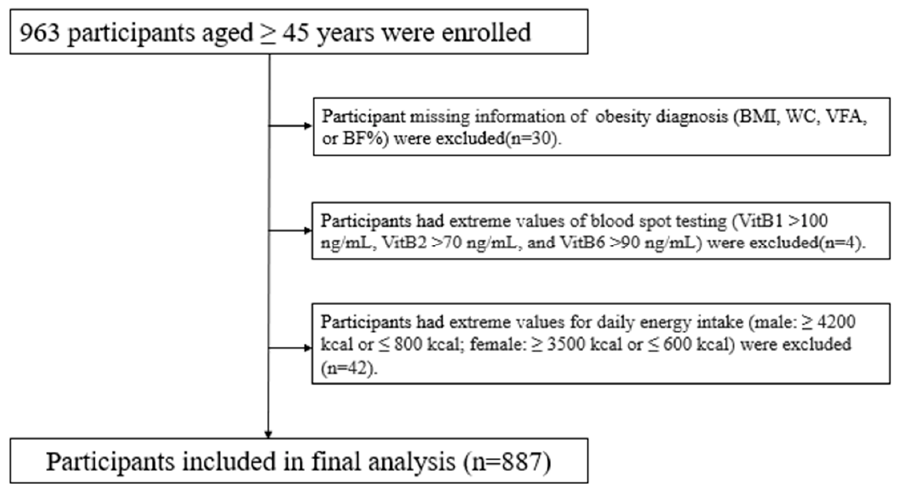
Figure 1. Flowchart of the inclusion of the study participants.